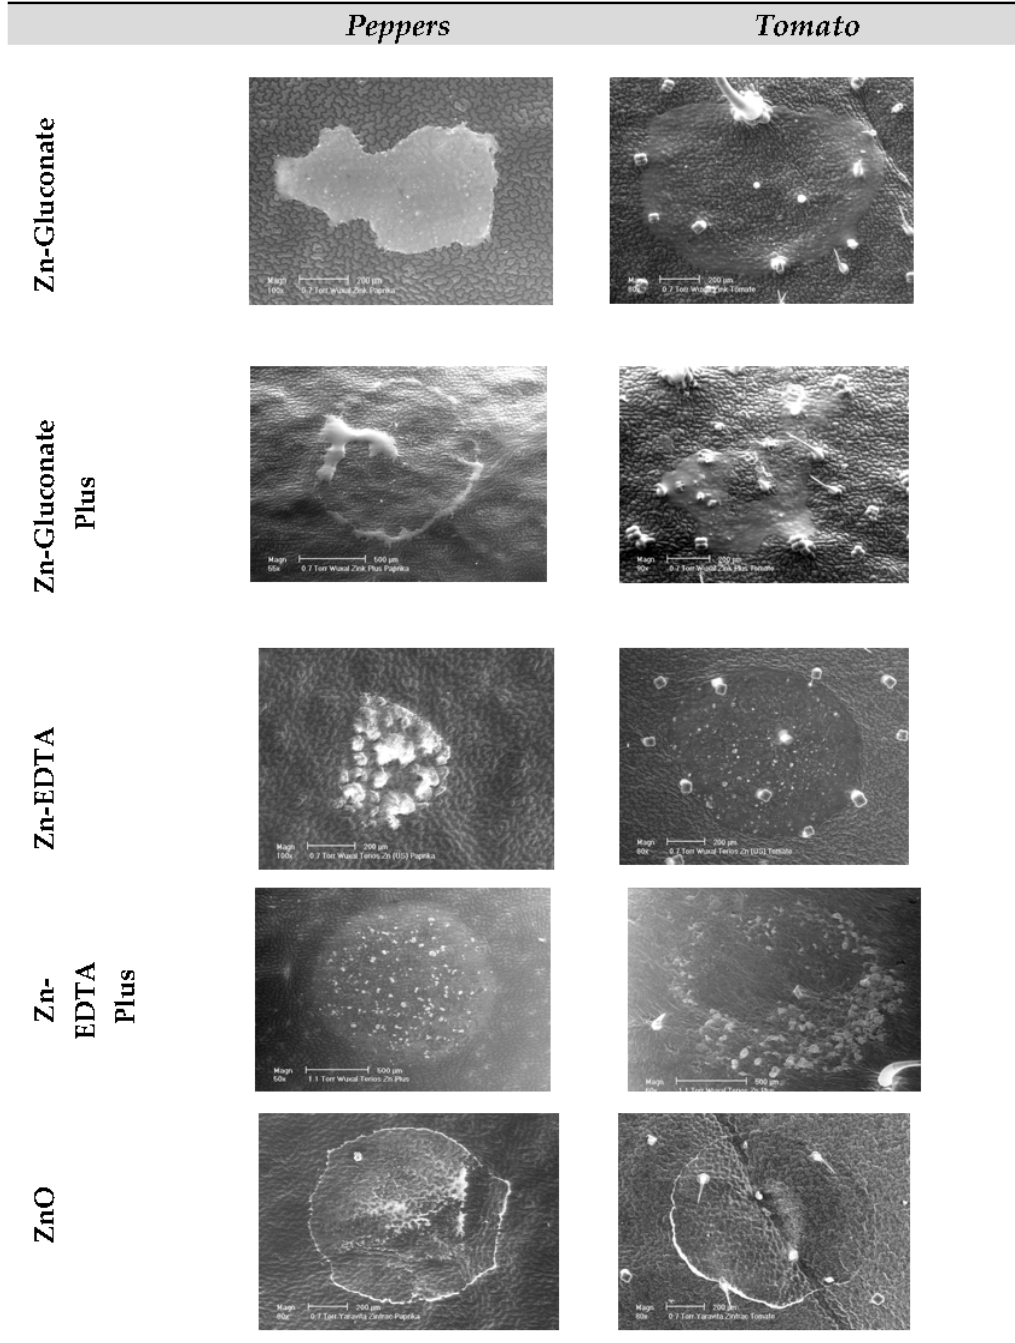
Figure 6. Representative micrographs taken with a scanning electron microscope (please note the scale of each figure). This picture table comprises the formulated zinc-based compounds used.